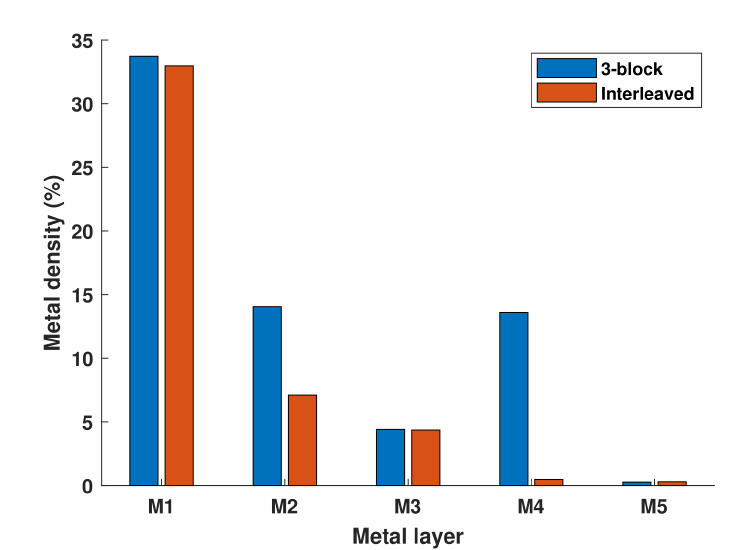
Figure 6. Average design metal density for different metal layers for 3 Block (left) and interleaved (right)